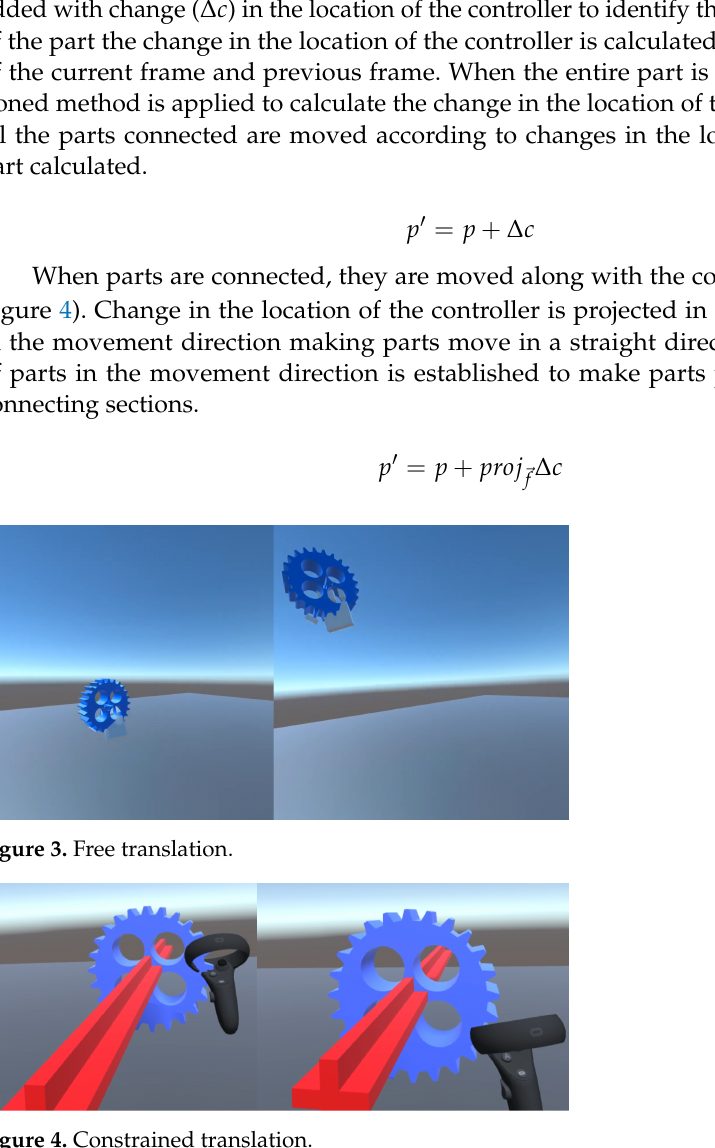
Figure 4. Constrained